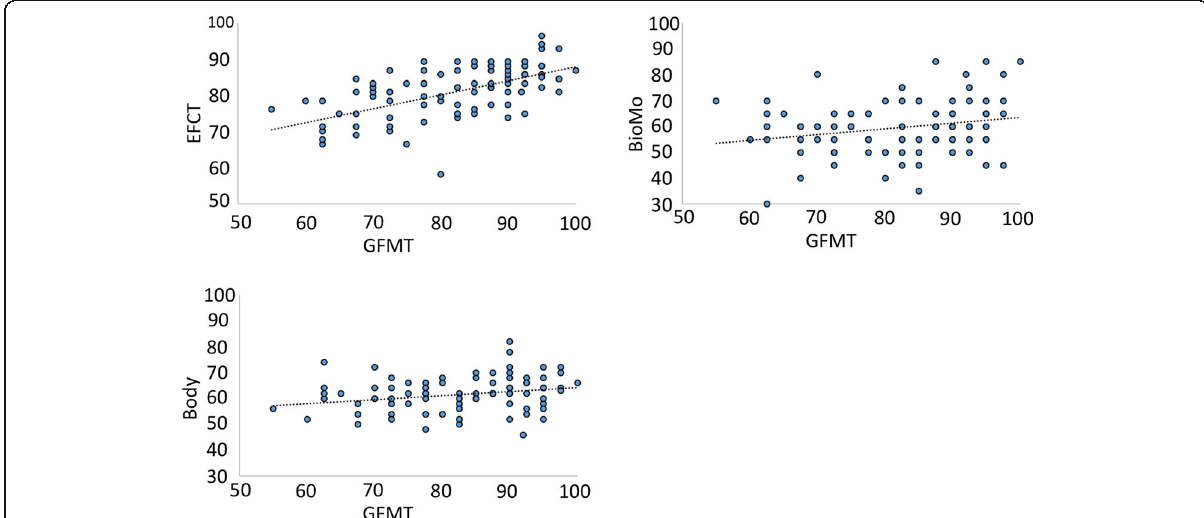
Fig. 5 Relationship between the Glasgow Face Matching Test (GFMT) and (1) the Expertise in Facial Comparison Test (EFCT), (2) the Body and (3) the Bio Motion